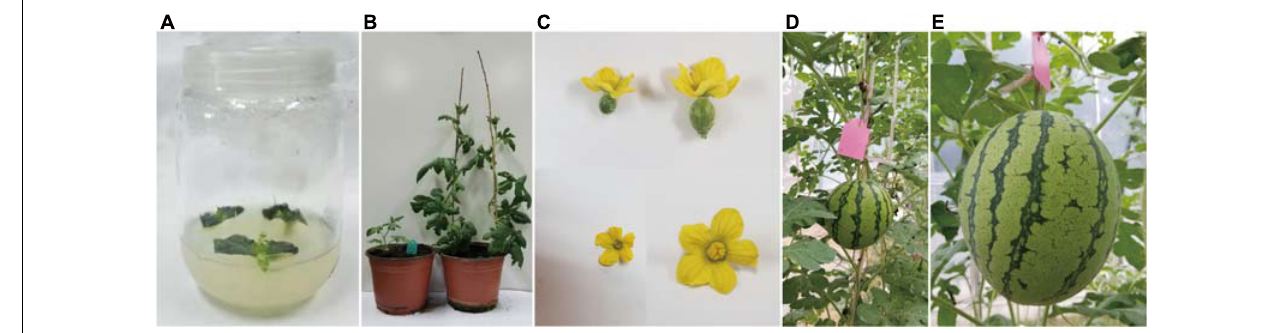
FIGURE 7 | Characteristics of the transgenic watermelon plants at different growth stages. (A) Bud regeneration from cotyledons after 3 weeks. (B) Enlarged adventitious shoots, which were transferred to plastic cups containing vermiculite. The plastic cup on the left contains transformed plants, whereas the plastic cup on the right consists of control plants. (C) Elongated plantlets. Female and male flowers of transgenic plants are presented on the left , whereas female and male flowers of control plants are presented on the right . (D) Representative fruit from a T 4 ClaPEX1 RNAi watermelon plant. (E) Representative fruit from a control “Kexi”